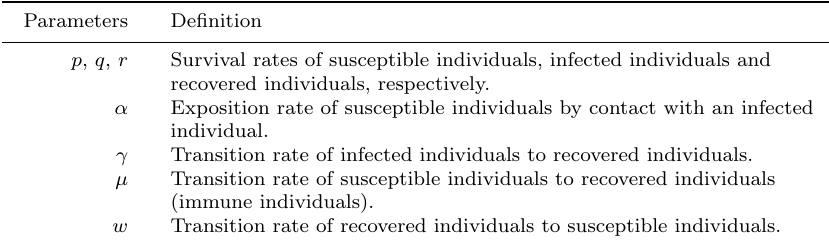
Table 1. Parameters in SIR model